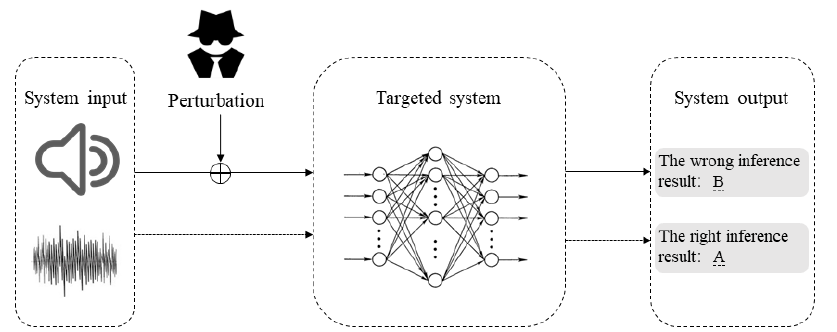
Figure 1. The general working flow of an adversarial attack in a Voice Processing